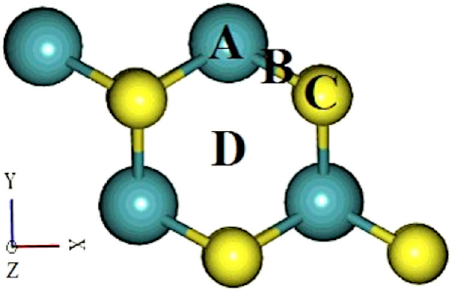
Fig. 6 MoS 2 monolayer con fi guration. Primary sites considered to position the adsorbents on the MoS 2 monolayer.